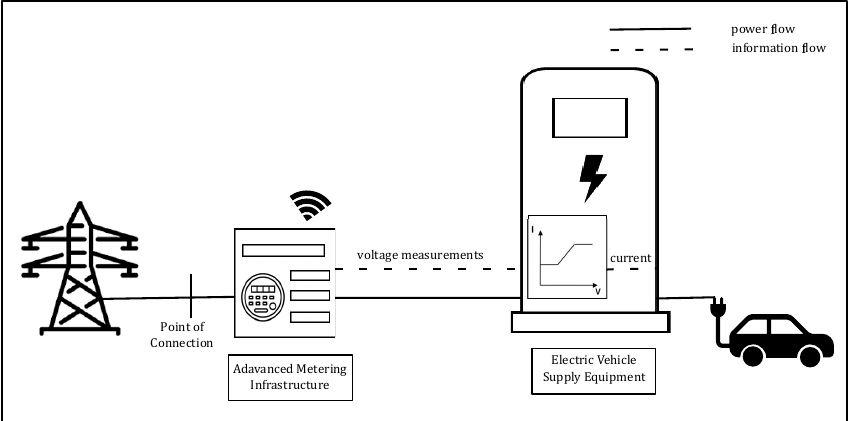
Figure 1. Voltage droop control mechanism.